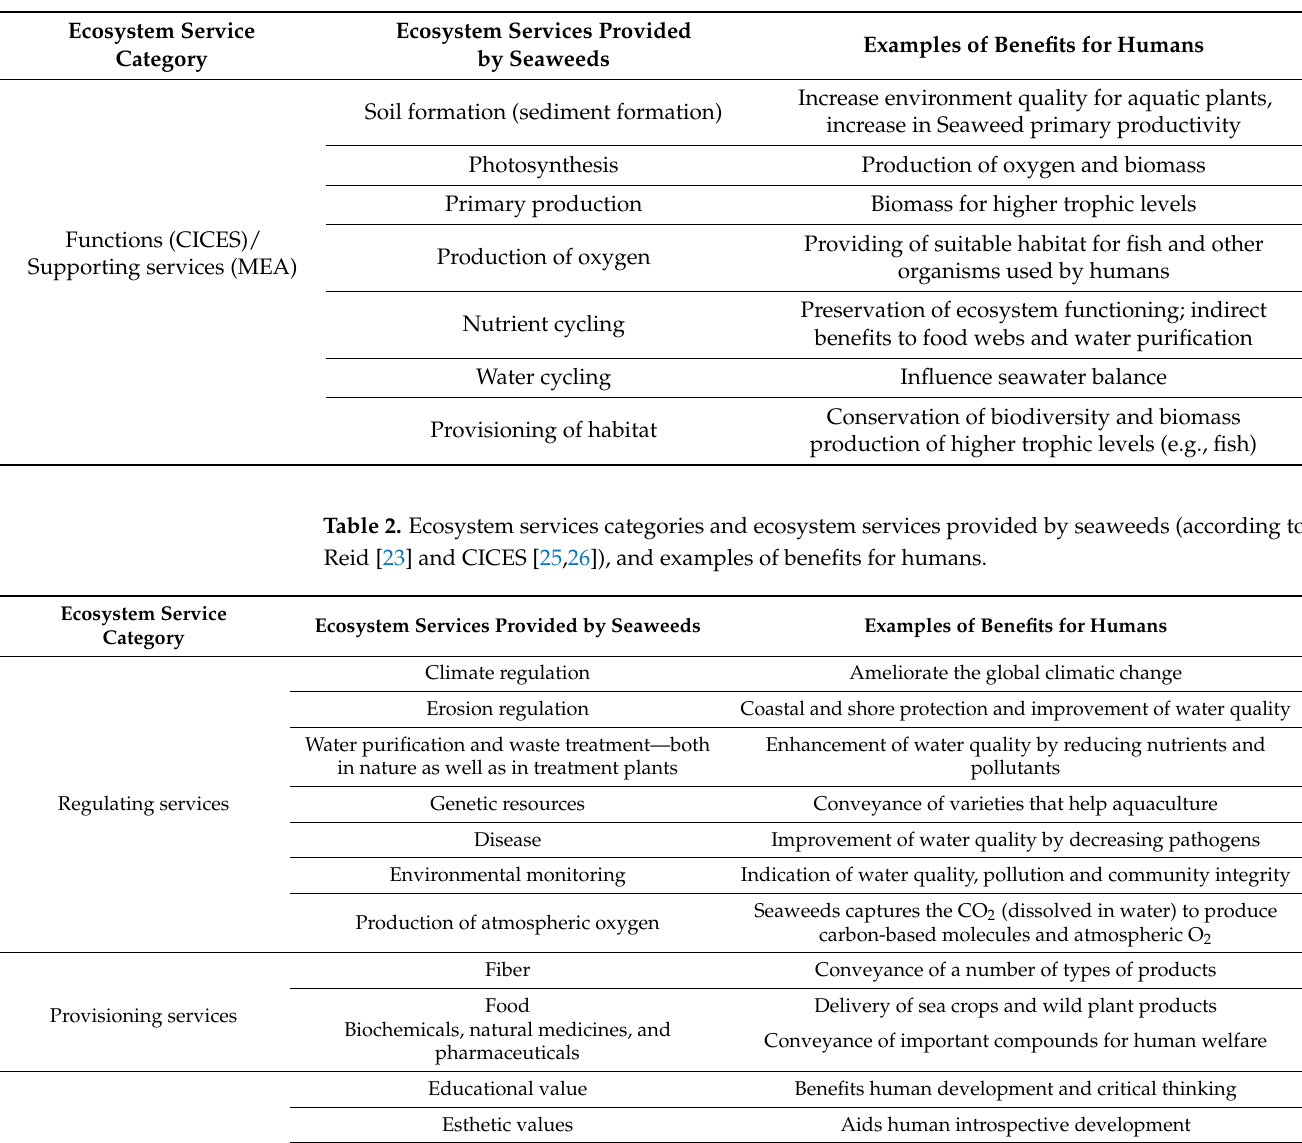
Table 1. Seaweeds functions (CICES)/supporting services (MEA) (according to Reid [23] and CI- CES [25,26]), and examples of benefits for humans.